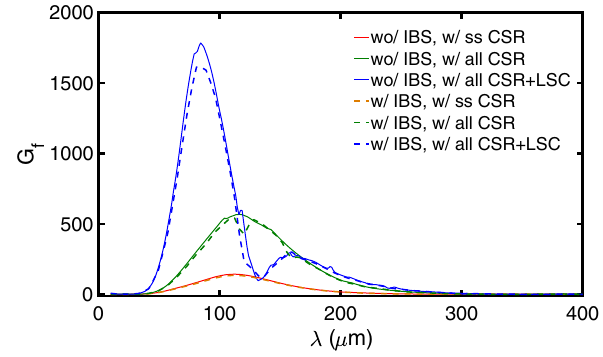
FIG. 13. Gain spectrum at the exit of the recirculating beamline with inclusion of different collective effects and with/without IBS. The all CSR includes steady-state, entrance, and exit transient